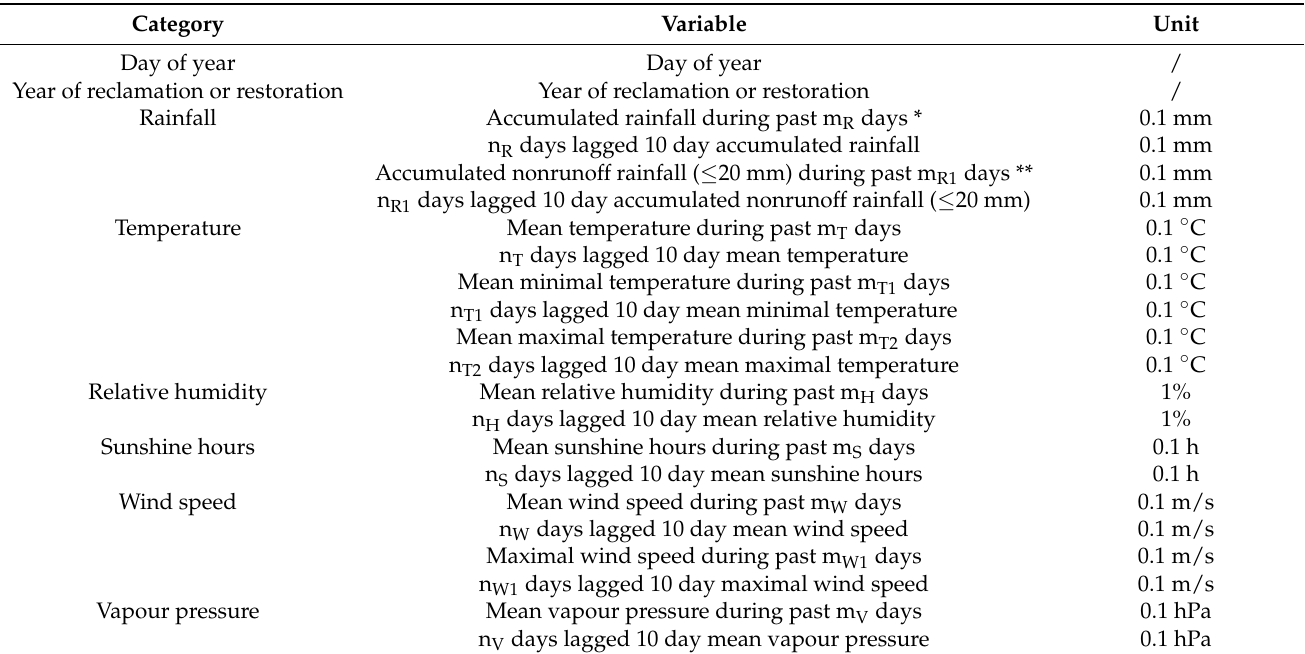
Table 2. Summary of explanatory variables of the EVI